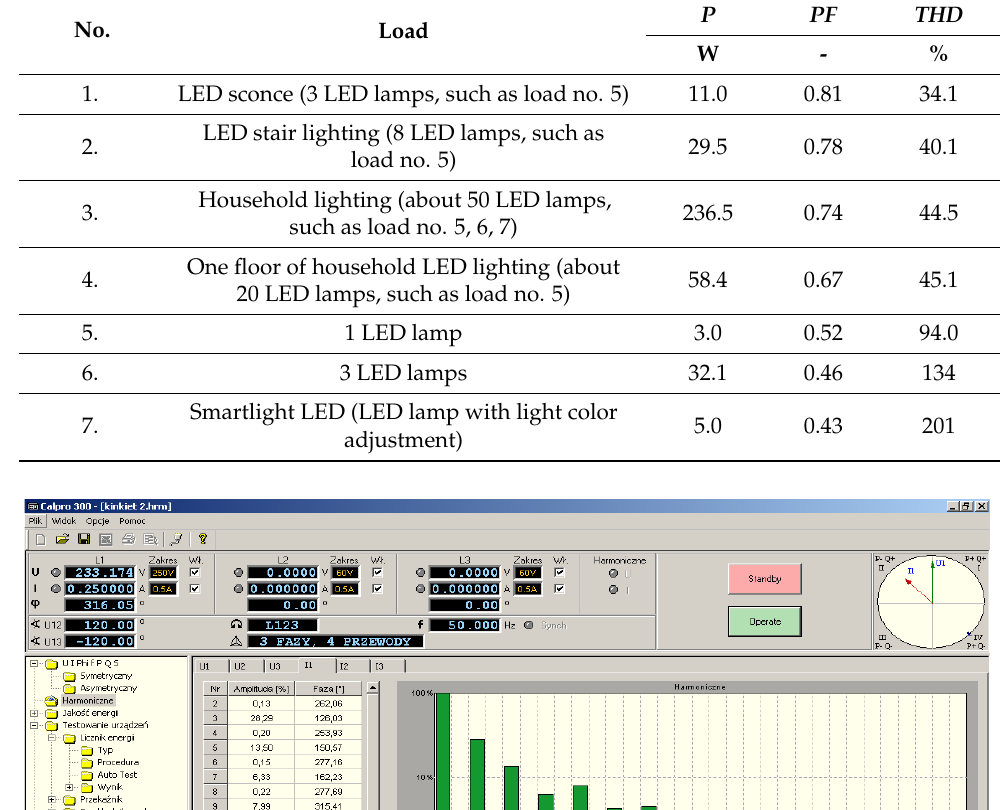
Table 1. Lighting used in the investigation of the meters.